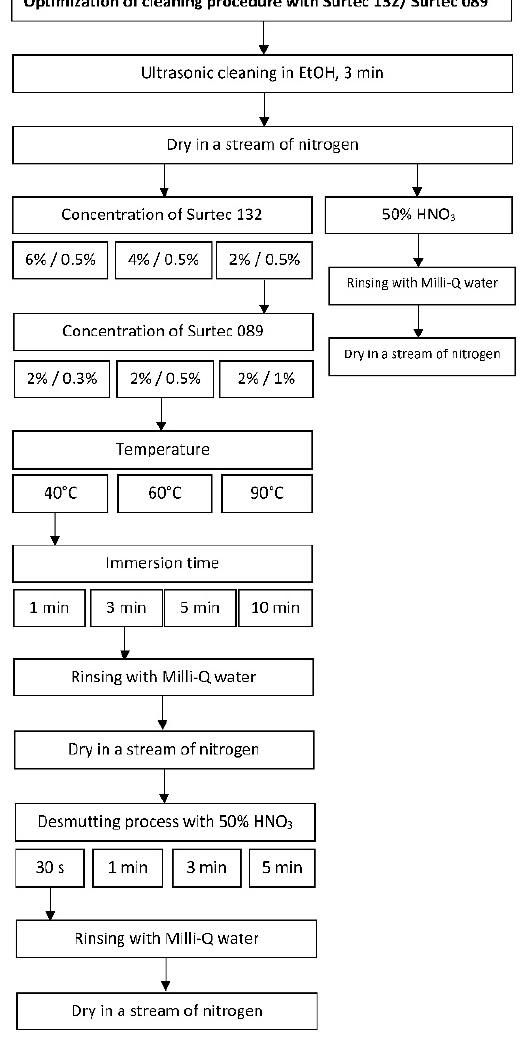
Figure A1. A schematic presentation of the selection of chemical pre-treatment of AA3003 substrate using commercial SurTec cleaners and HNO 3 as a desmutting agent.